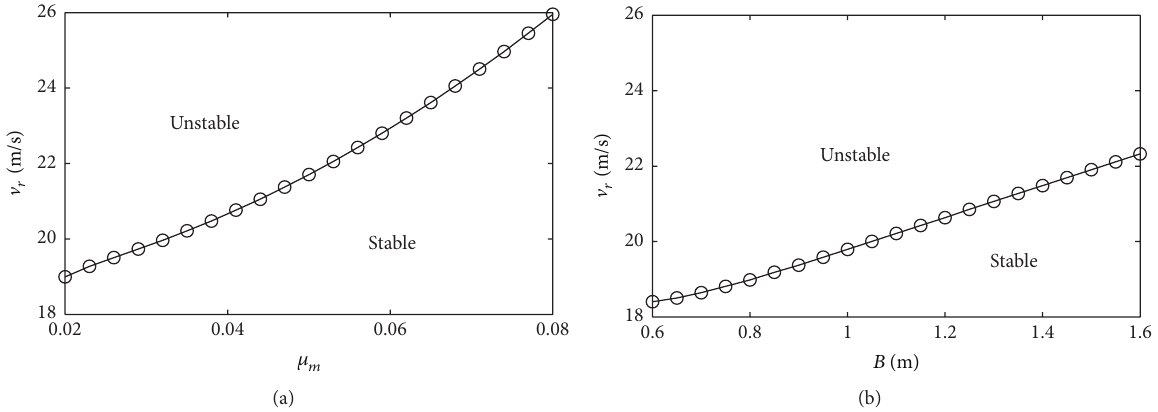
Figure 14: Influences of friction coefficient and strip width on system